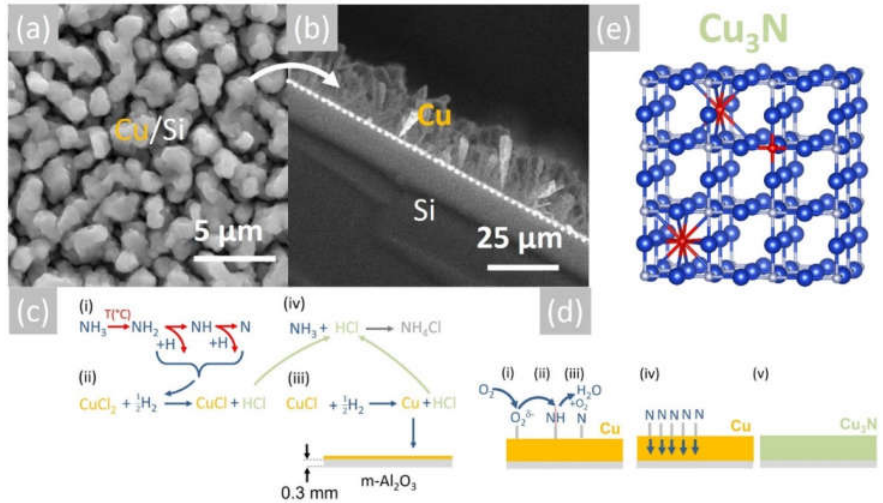
Figure 3. ( a ) SEM image of Cu on Si obtained at 600 °C and ( b ) section showing the formation of Cu rods on Si; ( c ) reaction mechanism for the deposition of Cu and ( d ) reaction mechanism for the conversion of Cu into Cu 3 N obtained under NH 3 : O 2 ; ( e ) stick and ball model of the anti-ReO 3 cubic crystal structure of Cu 3 N; large blue spheres (Cu), small grey spheres (N) and red spheres (O). More specifically, the 0.1 M solution of CuCl 2 is initially converted into a mist of liquid drops and mixed with NH 3 , which is soluble in CH 3 CH 2 OH [29]. Subsequently, the liquid drops are vaporized at an elevated temperature, and the CH 3 CH 2 OH gives C 2 H 4 and H 2 O according to the reaction C 2 H 5 OH C 2 H 4 + H 2 O. No carbon is released from the